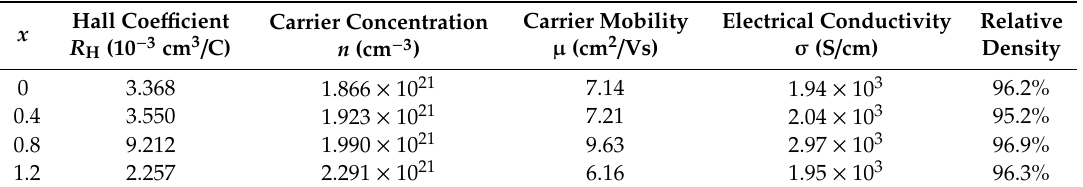
Table 1. Chemical composition and some physical parameters of x vol.% Cu–Te/Cu 2 SnSe 3 composites at room temperature.